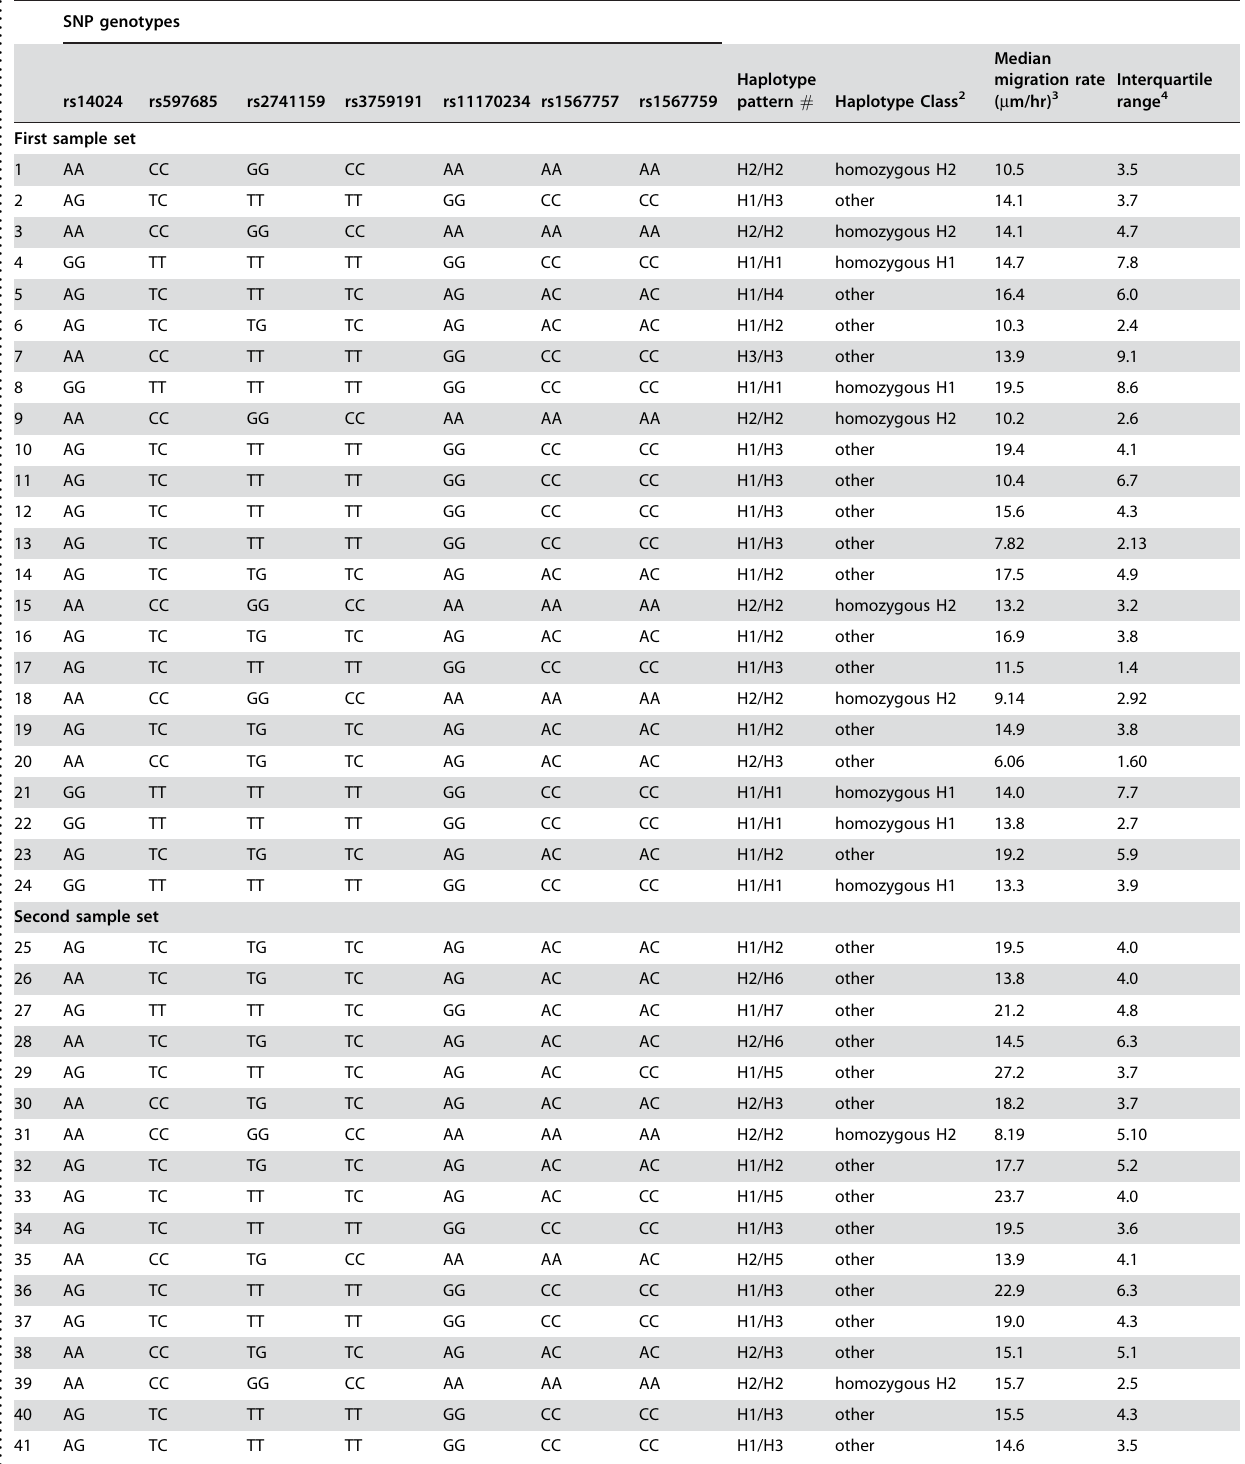
Table 3. KRT1 -interval SNP 1 genotypes, haplotype patterns and cell migration rates of the 41 HEK samples. .. ... .... ... ... .... ... ... .... ... ... .... ... ... .... ... ... .... ... ... .... ... ... .... ... ... .... ... ... .... ... ... .... ... ... .... ... ... .... ... ... .... ... ...